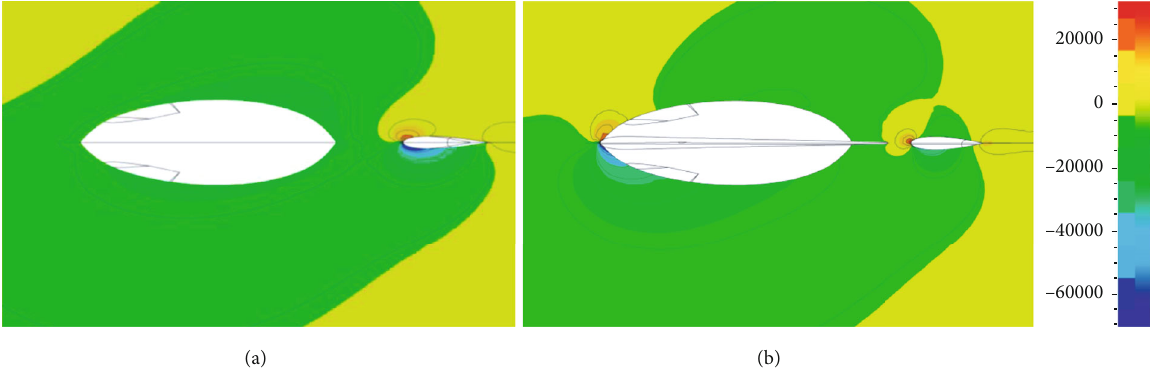
Figure 9: The pressure contours of the tuna body on the cut plane of Z = 0 : 12 m at a yaw angle of 9.5 ° in the depression and erection states, respectively: (a) the pressure contour of the body when all the medians are depressed; (b) the pressure contour of the body when all the medians are erected. Note: the white ellipses are the cut sections of the body and second dorsal fi n,